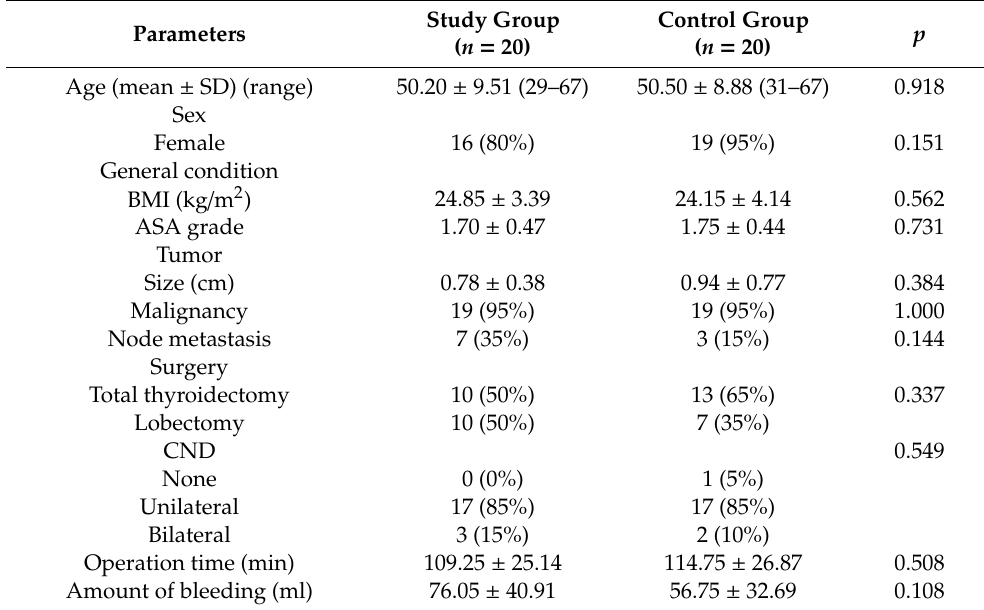
Figure 1. Flow chart of the clinical trial. Table 1. Demographic data of the patients (N = 40).